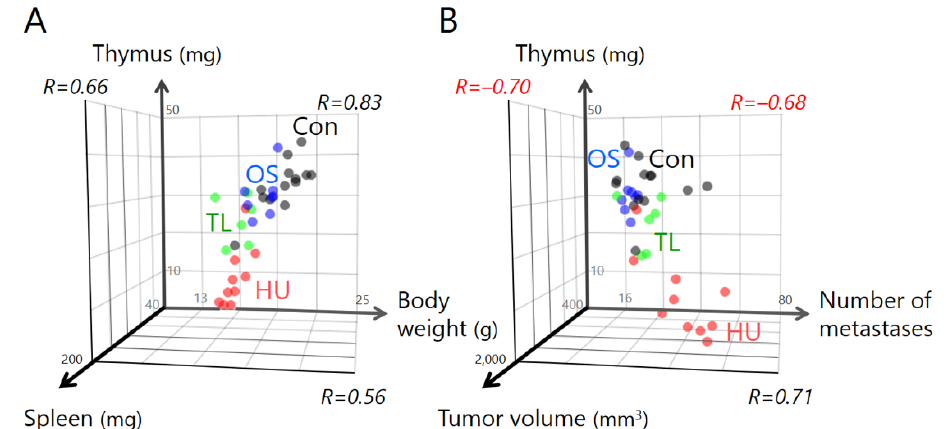
Figure A1. Scatterplot and correlation in four suspension conditions at 21 days after inoculation of LM8 cells. ( A ) Positive correlation between body weight, spleen weight, and thymus weight; ( B ) negative correlation between number of metastases or tumor volumes, and thymus weight. Black dots, standard housing control (Con) ( n = 13); red dots, hind-limb unloading (HU) ( n = 10); green dots, temporary loading during HU (2 h per day) (TL) ( n = 6); blue dots, orthostatic suspension (OS) ( n = 8). R, correlation coefficient.